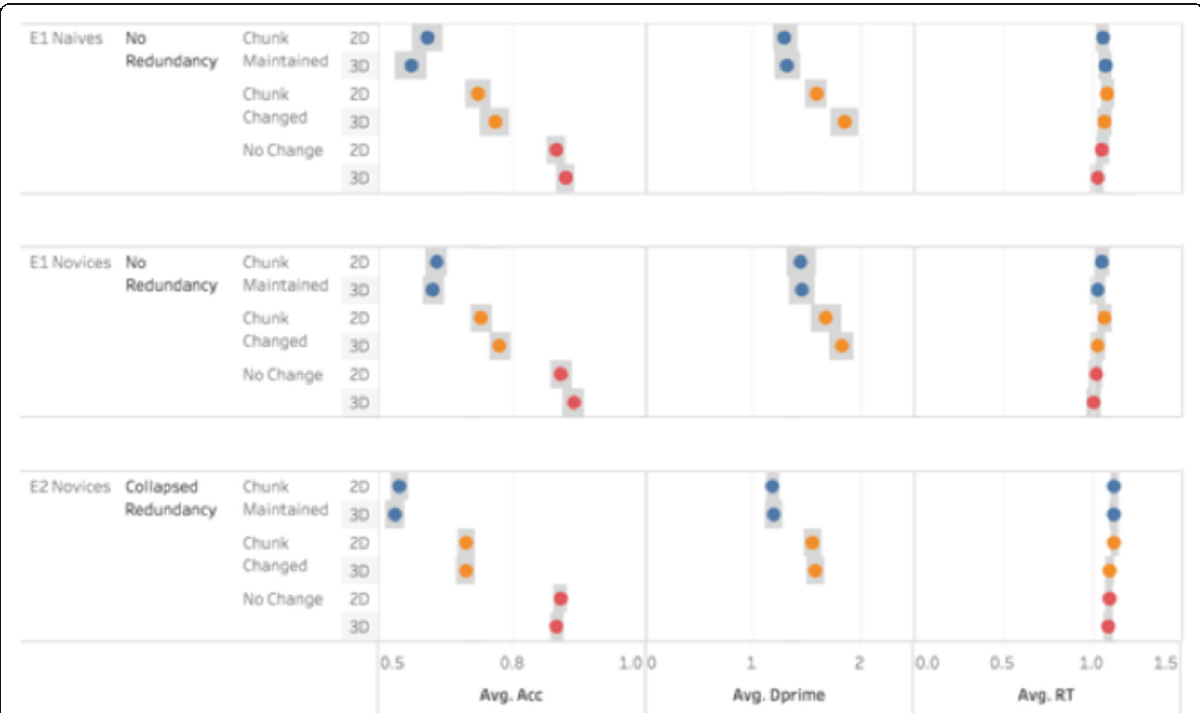
Fig. 3 Accuracy, dprime, and response time across Experiments 1 and 2 (collapsed across redundancy manipulations). No reliable performance differences were observed between the 2D and 3D arrangements, but performance was reliably higher for chunk-changed trials compared to chunk-maintained trials for both accuracy and Dprime. Circle = group means, gray rectangles = standard